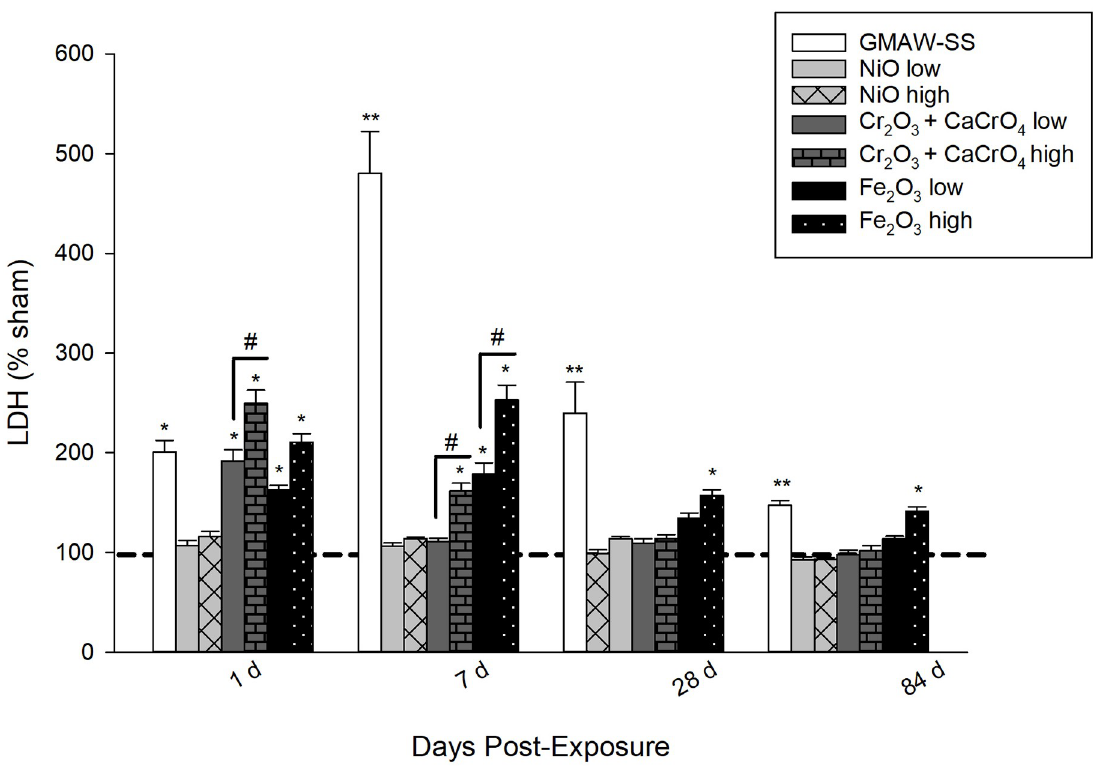
Fig 4. LDH activity, measured in the BAL fluid and indicative of lung cytotoxicity, after exposure to GMAW-SS fume or metal oxides. Data presented as percent change from sham (dashed line– 100%). � p < 0.0001 compared to sham; �� p < 0.0001 compared to sham and all other low-dose groups; # p < 0.0001 compared to low- and high-dose metal oxides within a group.